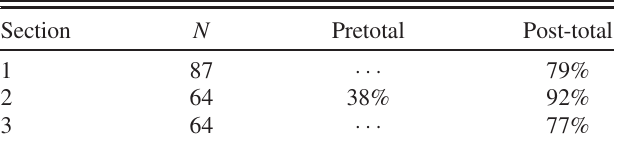
TABLE V. Average percentage total scores on the pretest and post-test for the tutorial group. The pretest was administered after traditional instruction but before the tutorial only in Sec. II due to time constraints in other sections. The symbol N refers to the matched number of students in a given section who took both the pretest and post-tests.